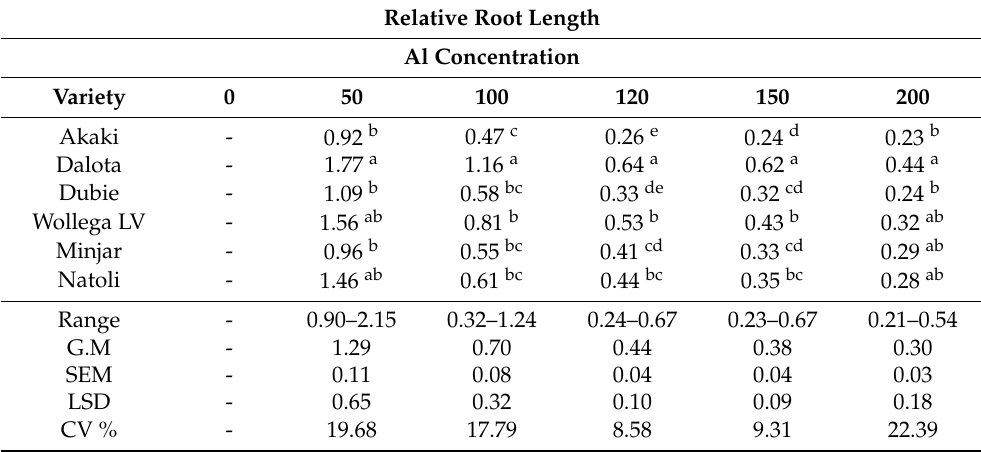
Table 3. Mean relative root growth of chickpea genotypes for the five Al concentrations (50, 100, 120, 150 and 200) µ M relative to 0 µ M Al.